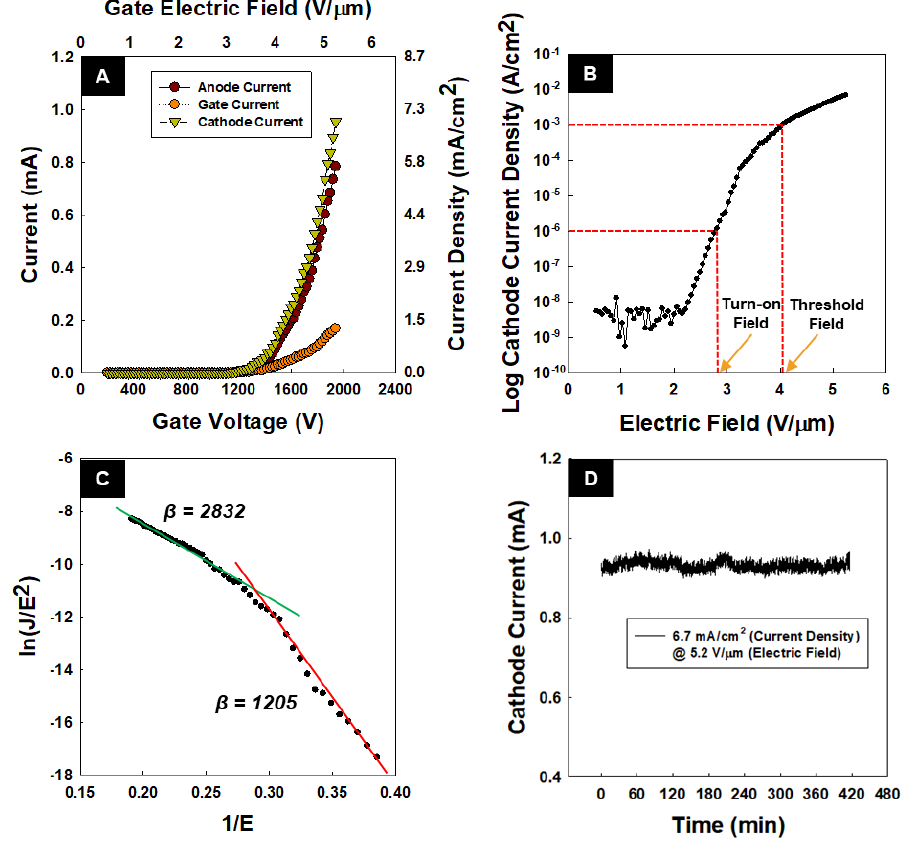
Figure 4. ( A ) I – V curve; ( B ) semi log plot; ( C ) the FN plot; ( D ) stability of CNT emitter. Figure 4. ( A ) I–V curve; ( B ) semi log plot; ( C ) the FN plot; ( D ) stability of CNT